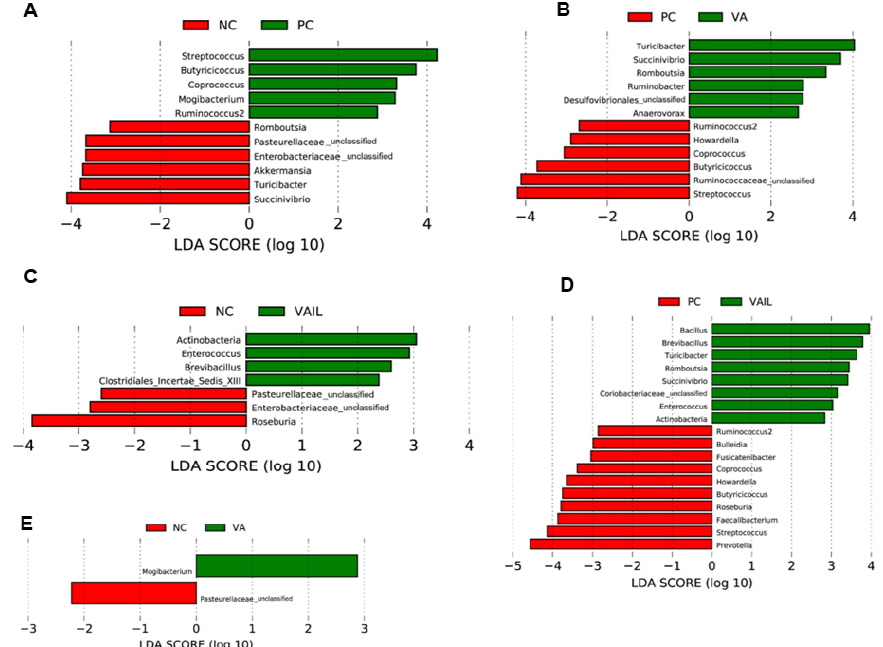
Figure 6. Histograms of colon microbiota composition in pigs fed with very low protein diets supplemented with isoleucine (Ile) at NRC and valine (Val) above NRC levels, or a combination of the two using linear discriminant analysis (LDA) with effect size (LEfSe). ( A ) NC vs. PC, ( B ) VA vs. PC, ( C ) VAIL vs. NC, ( D ) VAIL vs. PC, ( E ) VA vs. NC. PC: positive control, standard protein diet; NC: negative control, very low protein diet containing first four limiting amino acids (i.e., lysine, methionine, threonine, and tryptophan) at NRC (2012) levels; VA: NC containing Val above NRC level; IL: NC containing Ile at NRC level; VAIL: NC containing Val above NRC and Ile at NRC levels. n =